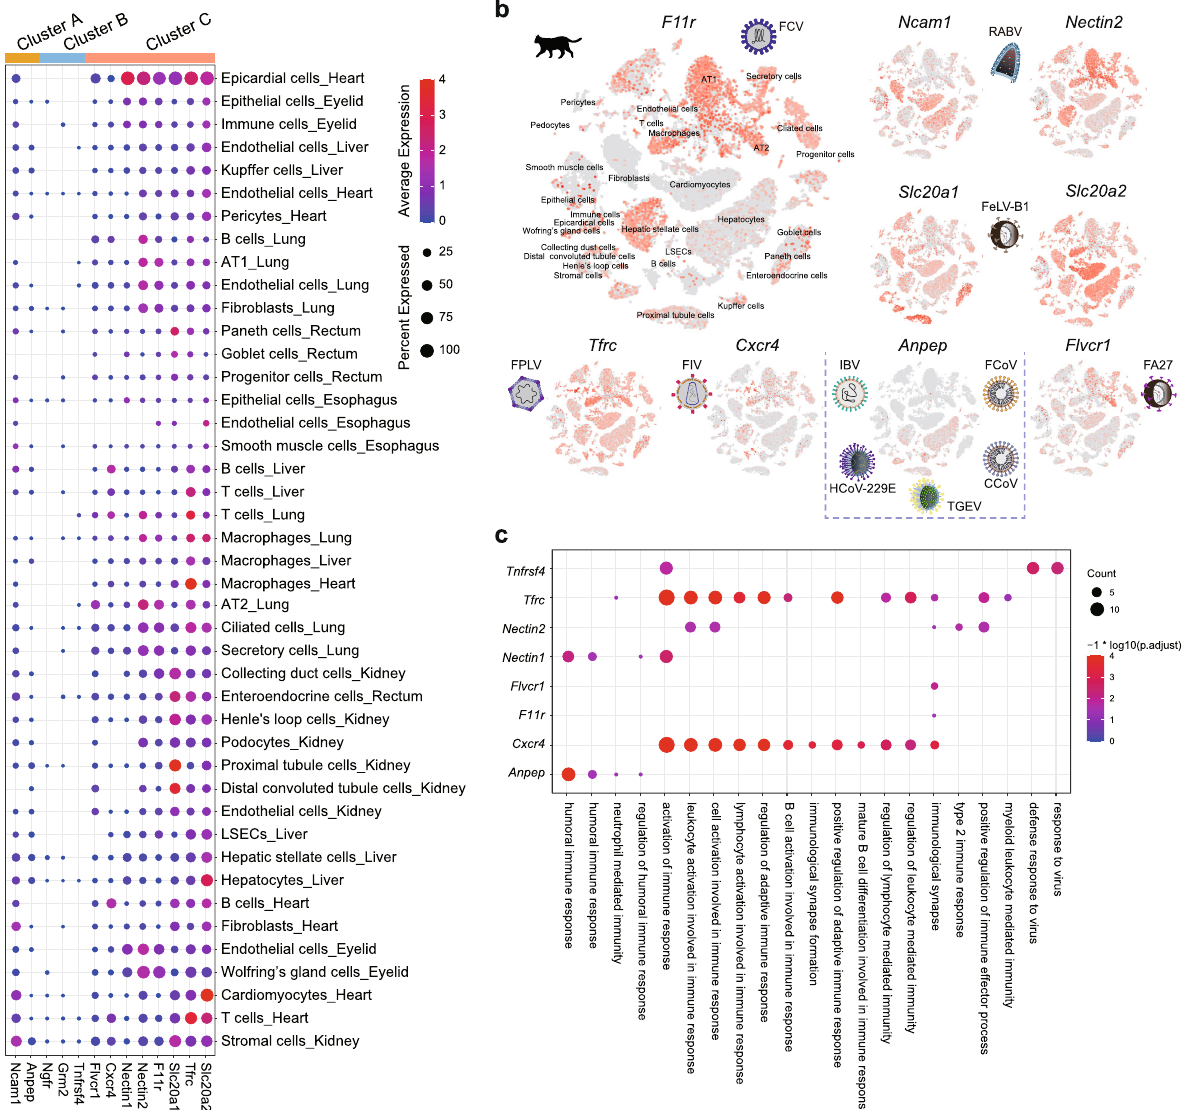
Fig. 4 Cross-talk landscape of cat cells and representative feline viruses. a Dot plot showing expression percentages and average expression levels of virus receptors (indicated below) in each cell types (indicated on the right) of cat cells. b Feature plot showing the expression patterns of virus receptors ( F11r , Ncam1 , Nectin2 , Slc20a1 , Slc20a2 , Tfrc , Cxcr4 , Anpep , Flvcr1 ) in cat cells. Corresponding virus species and image were illustrated approximate to the feature plot. CCov, canine coronavirus; FA27, feline leukemia virus strain C; FCV, feline calicivirus; RABV, Rabies lyssavirus; FCoV, feline coronavirus; FeLV- B1, feline leukemia virus strain B; FPLV, feline panleukopenia virus; FIV, feline immunode fi ciency virus; HCoV-229E, human coronavirus 229E; IBV, infectious bronchitis virus; TGEV, transmissible gastroenteritis virus. c Bubble plot showing the immune-related GO terms of eight representative virus receptors in cat. The dot color was positively correlated with enrichment levels, whereas dot size was determined by count of genes in that GO term. P - values were calculated using hypergeometric test. Multiple comparisons adjustment was performed using Benjamini and Hochberg method. Exact P -value and source data were included in the Source Data fi lymphocytes 44 . In contrast, Tnfrsf4 was expressed poorly in feline cells, implying a receptor usage preference of FIV. Receptors for different strains of the same virus show a high degree of heterogeneity. For instance, Slc20a1 and Slc20a2 are the receptors for feline leukemia virus (FeLV) strain B/lambda-B1 45 , whereas Flvcr1 is the receptor for the FeLV strain C/FA27 46 .